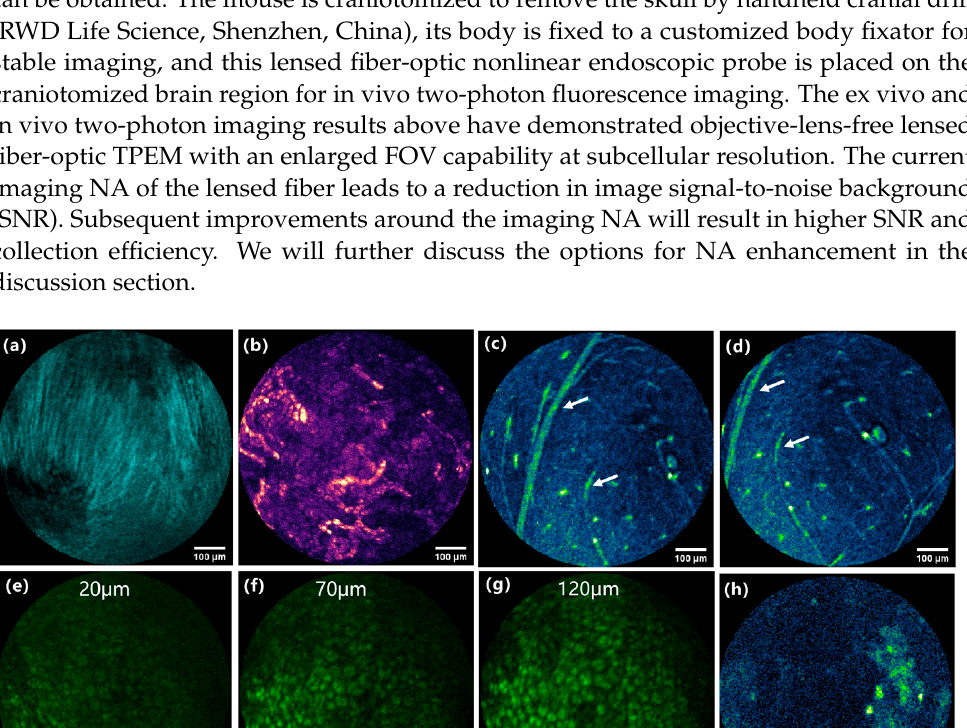
9 of 12 Figure 7. ( a ) Two-photon imaging of a 50 µm square standard grid for FOV measurement. Scale bar: 100 µm; and ( b ) Two-photon imaging lateral resolution measurement. Red circle: measured data; Blue line: Gaussian fi t. The two-photon endomicroscopic imaging of ex vivo organs, such as the heart, kid- ney, brain, and stomach wall, of an eGFP-labeled (enhanced green fl uorescent protein) mouse was fi rst performed to verify the enlarged FOV imaging capability. Figure 8a illus- trates the heart muscle with long cardiomyocyte structures (the power under the probe is 65 mW, 10 frames averaged), and some regions of the cardiomyocyte structures have a